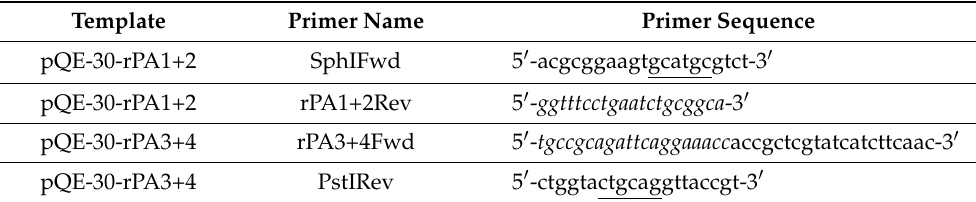
Table 1. Oligonucleotides used for construction of rPA83m synthetic